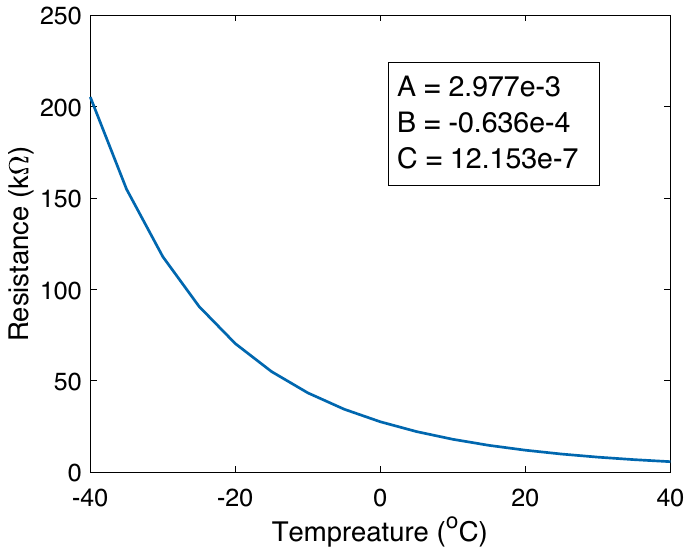
Figure 3. Example of measured and fitted resistance response vs. temperature of the 10K NTC thermocouple.